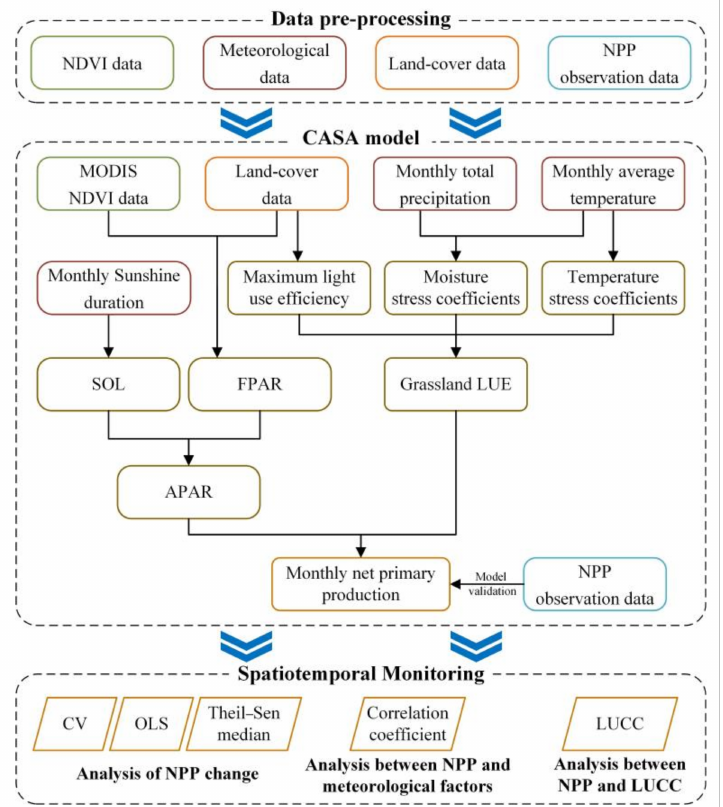
Figure 2. The flowchart of CASA model and NPP analysis methods in this